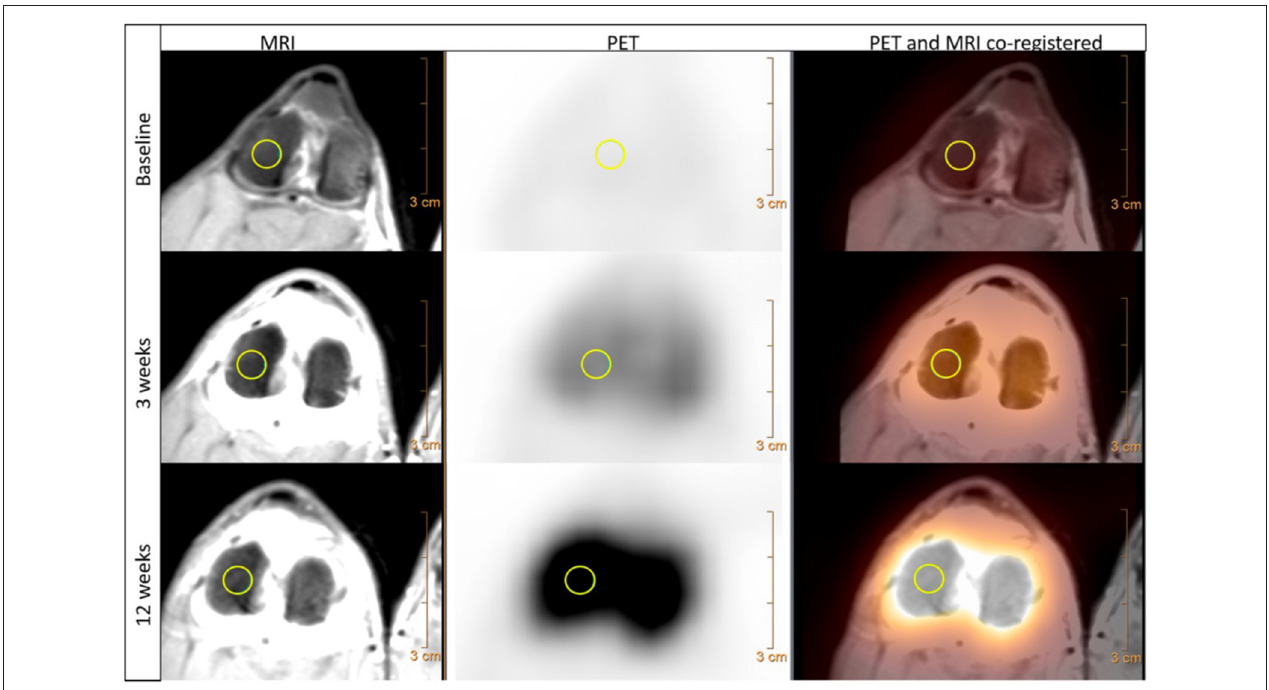
FIGURE 9 | MRI, PET and PET/MRI co-registered transverse views of a canine stifle using Na18F before (baseline), 3 weeks and 12 weeks following CCL transection. The MRI images used a proton density weighted sequence and depict the detailed anatomy of the stifle. The Na18F PET imaging shows an increase of positron emissions compared to baseline at both 3 weeks and then again at 12 weeks post CCL transection, indicating an increase bone uptake of Na18F in response to increase bone metabolism following joint destabilization. Both images are co-registered allowing direct assessment of both the anatomic and metabolic changes, with a manually drawn 6mm 3D region of interest present on the lateral femoral condyle (yellow circle). MRI – Magnetic resonance imaging; PET – positron emission tomography; CCL – cranial cruciate ligament. Menendez M et al. Feasibility of Na18F PET/CT and MRI for Noninvasive In vivo Quantification of Knee Pathophysiological Bone Metabolism in a Canine Model of Post-traumatic Osteoarthritis. Mol Imaging. 2017: 16 (1–8); doi: 10.1177/1536012117714575. Reprinted under creative common